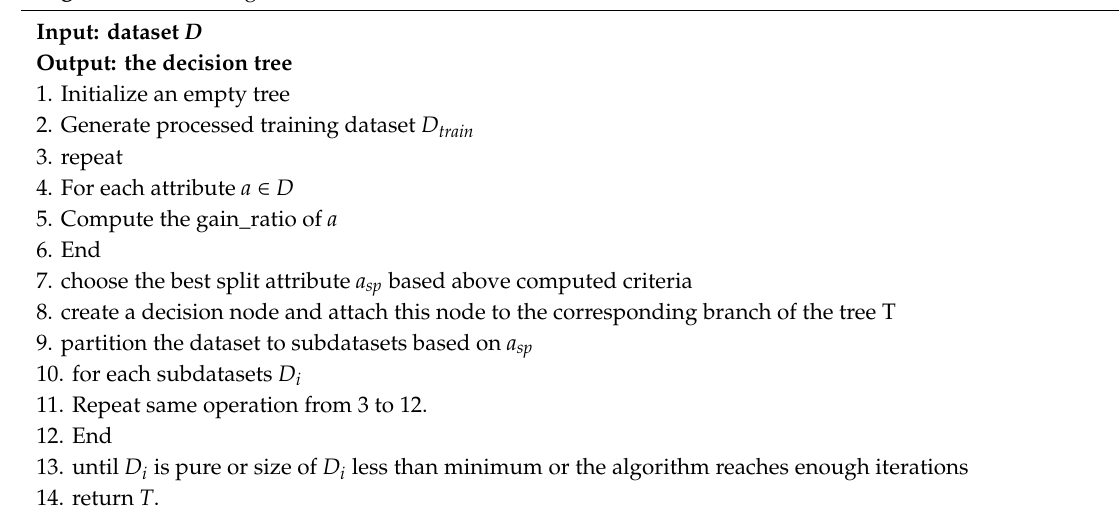
Algorithm 1. Training Decision